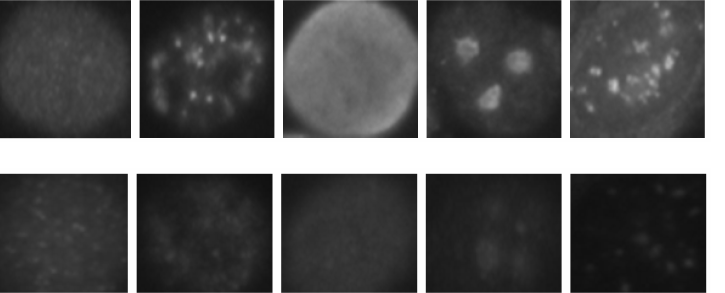
Figure 3. Two under-classes can be defined: ( Row 1 ) positive cells (high intensity) and ( Row 2 ) intermediate cells (low intensity).